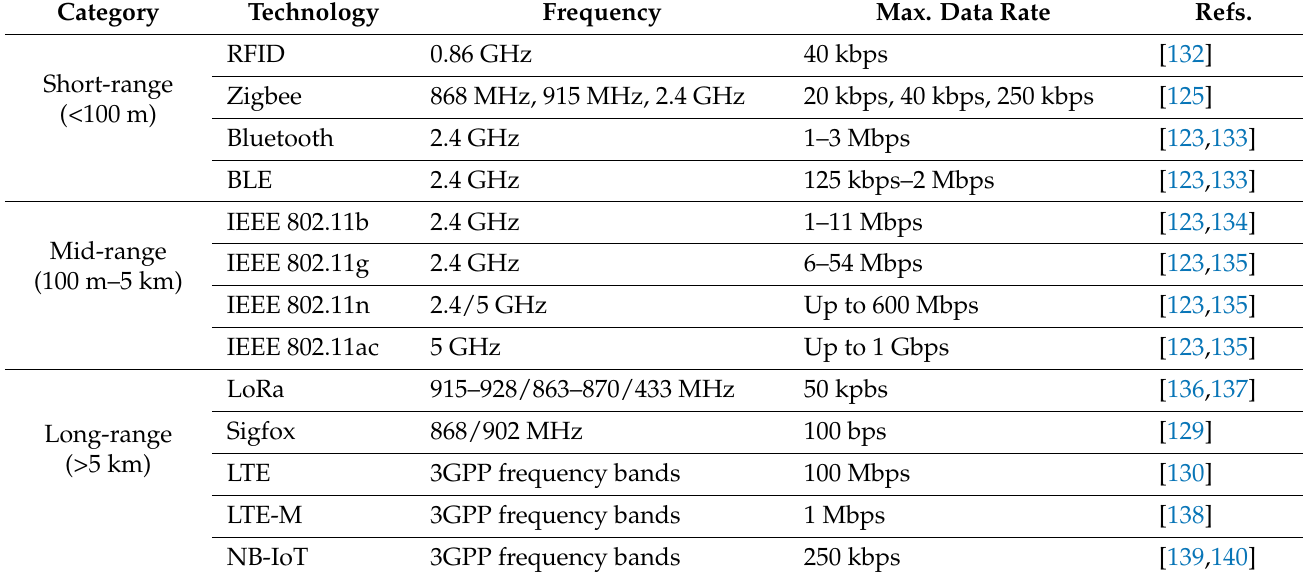
Table 5. Communication technologies utilized in industrial wearable